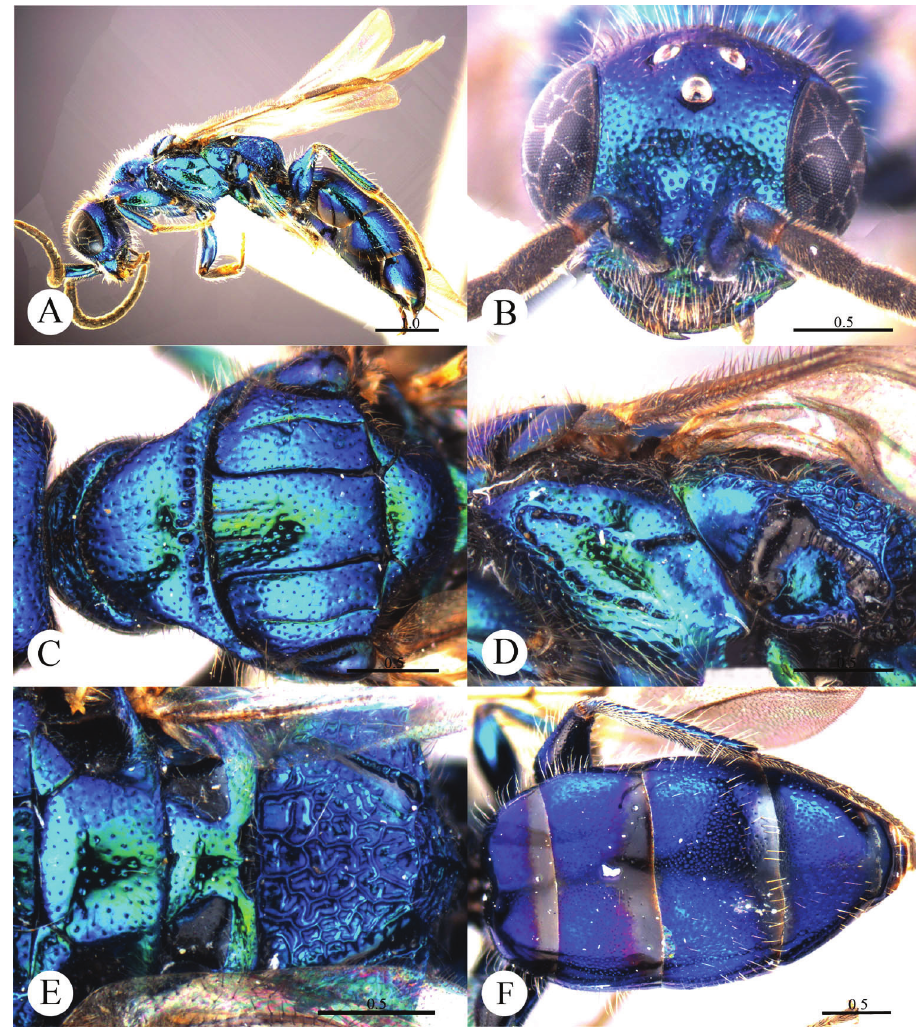
Plate 16. Cleptes villosus sp. n., holotype, male. A Habitus lateral B Head anterior C Pronotum and mes- oscutum dorsal D Mesopleuron and metapleuron lateral e Mesoscutellum, metanotum and propodeum dorsal F Metasoma dorsal. Scale bars in